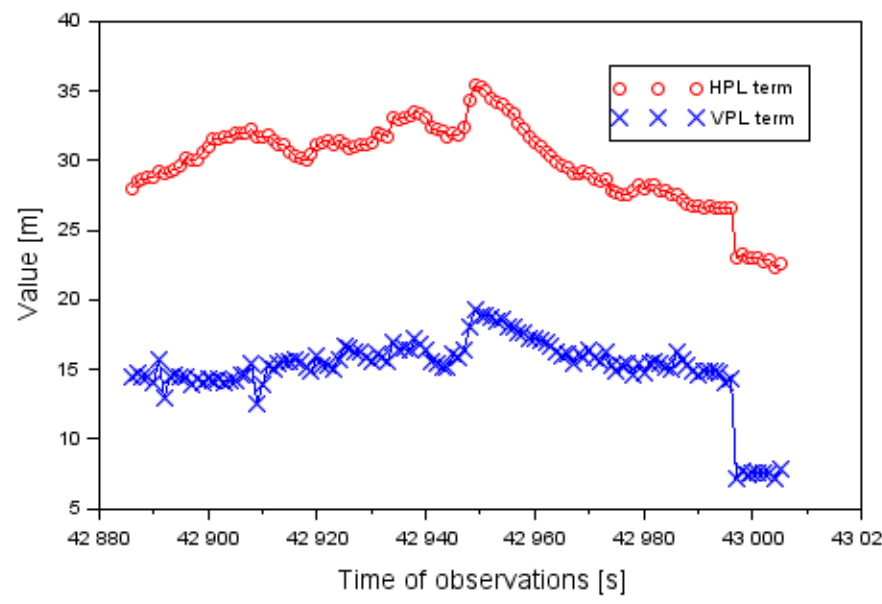
Table 4. Comparison of integrity of aircraft position in air tests in D ę blin and Che ł m.